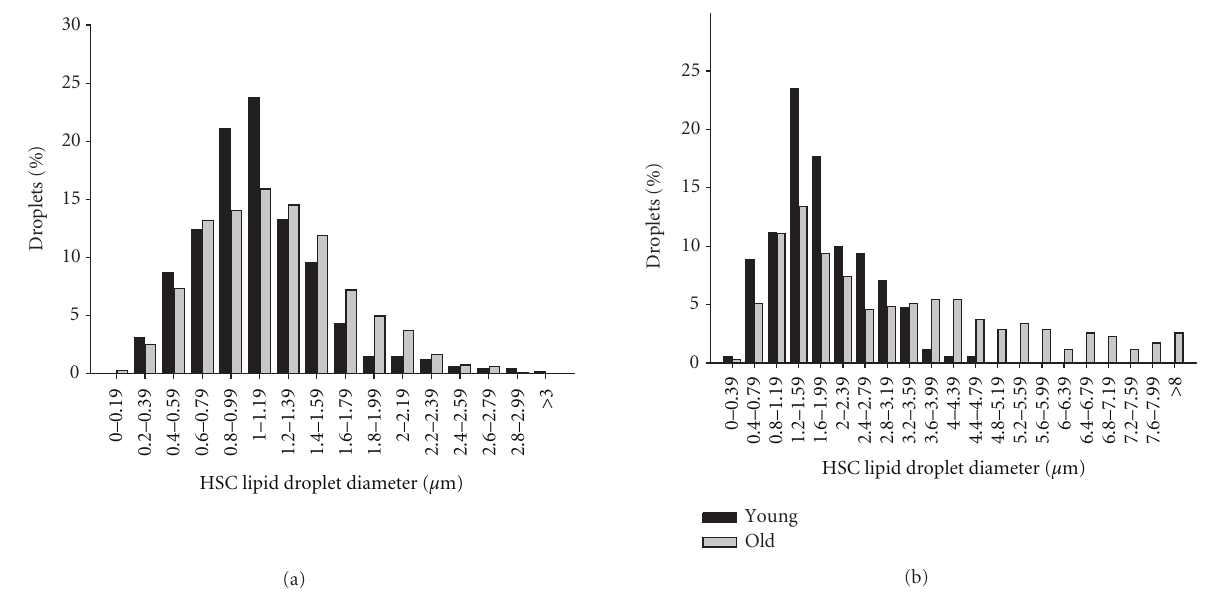
Figure 3: Frequency distribution of the diameter of the lipid droplets in HSC from rats (a) and mice (b). In both rats and mice, the distribution was skewed to the right in old